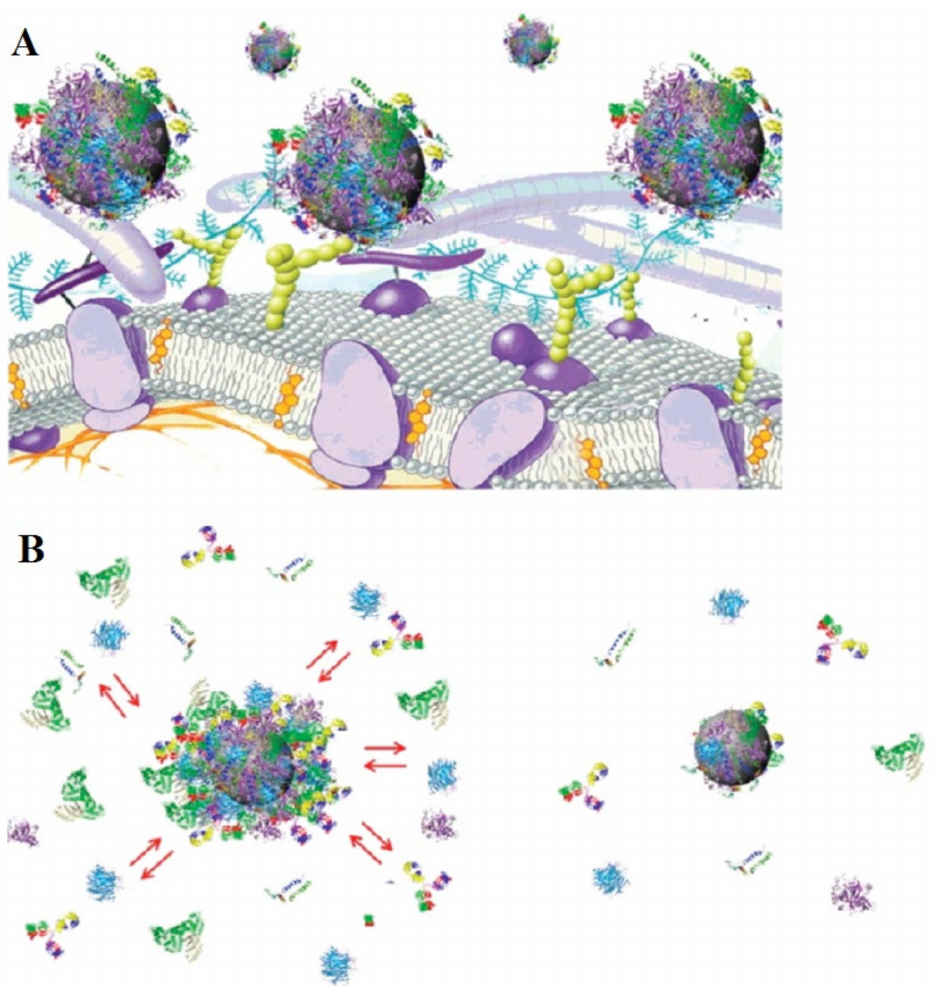
Figure 3. Illustrative diagram showing the interaction/exchange script and the probable NP–protein complex structure. ( A ) Representative drawing shows the possible exchange/interaction scenarios at the bio-nanointerface at the cellular level. ( B ) Representative drawingshows the structure of the NP–protein complexes in plasma affirming the outer weakly interacting layer of protein (left, full red arrows) and the hard slow exchanging corona of proteins (right). Adapted, with permission, from